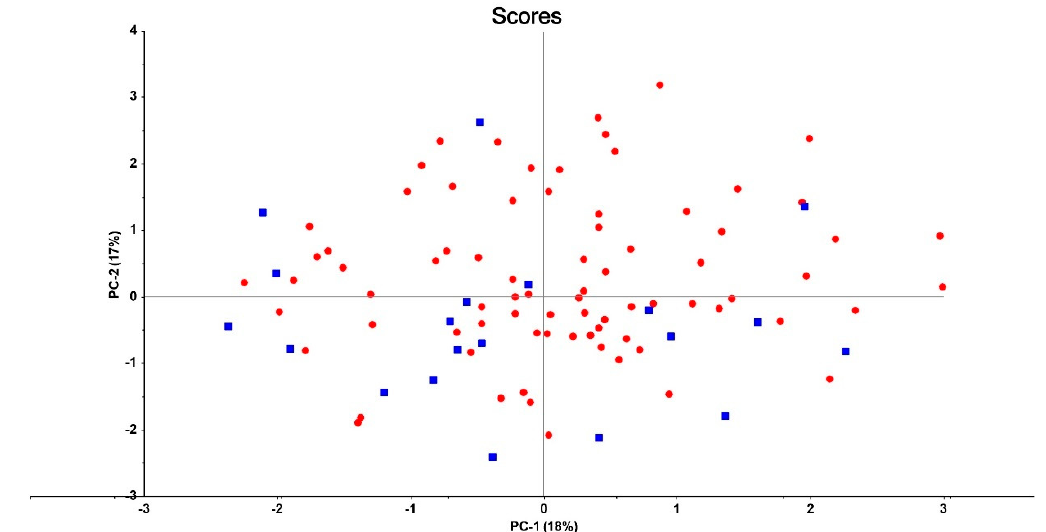
Figure 2. Plot of PC 1 and PC 2 explaining 35% of the variance.